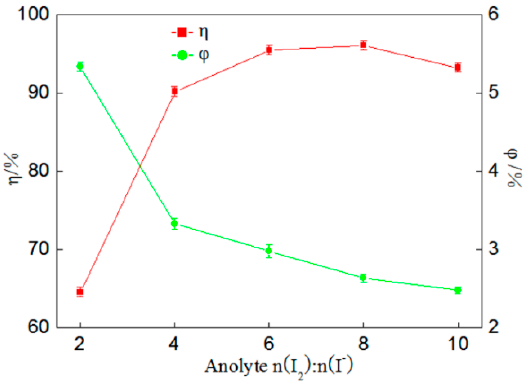
Figure 3. Influence of anolyte n(I 2 ):n(I − ) on percentage of gold deposition ( η ) and coulombic efficiency ( φ ).